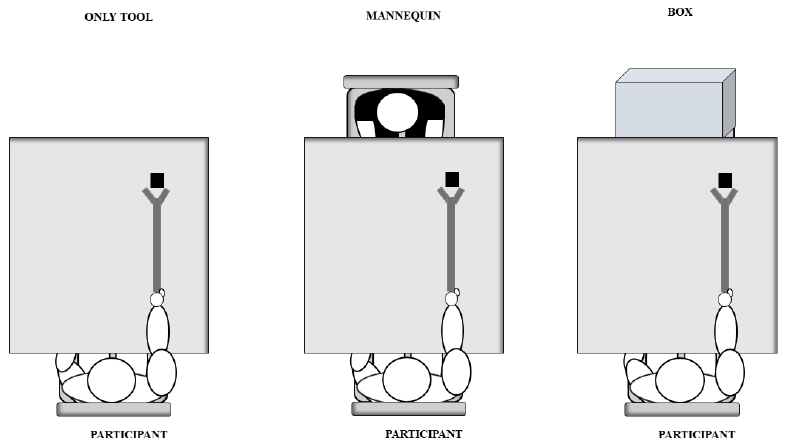
Figure 1. The three different tool-use training conditions. From left to right in the figure is shown the Only Tool condition (OnlyT group) in which participants performed the training in absence of stimuli, the Tool plus Mannequin condition (TM group) in which participants performed the training in a social context that is in presence of mannequin, and the Tool plus Object condition (TObj group) in which participants performed the training in front of a large box.